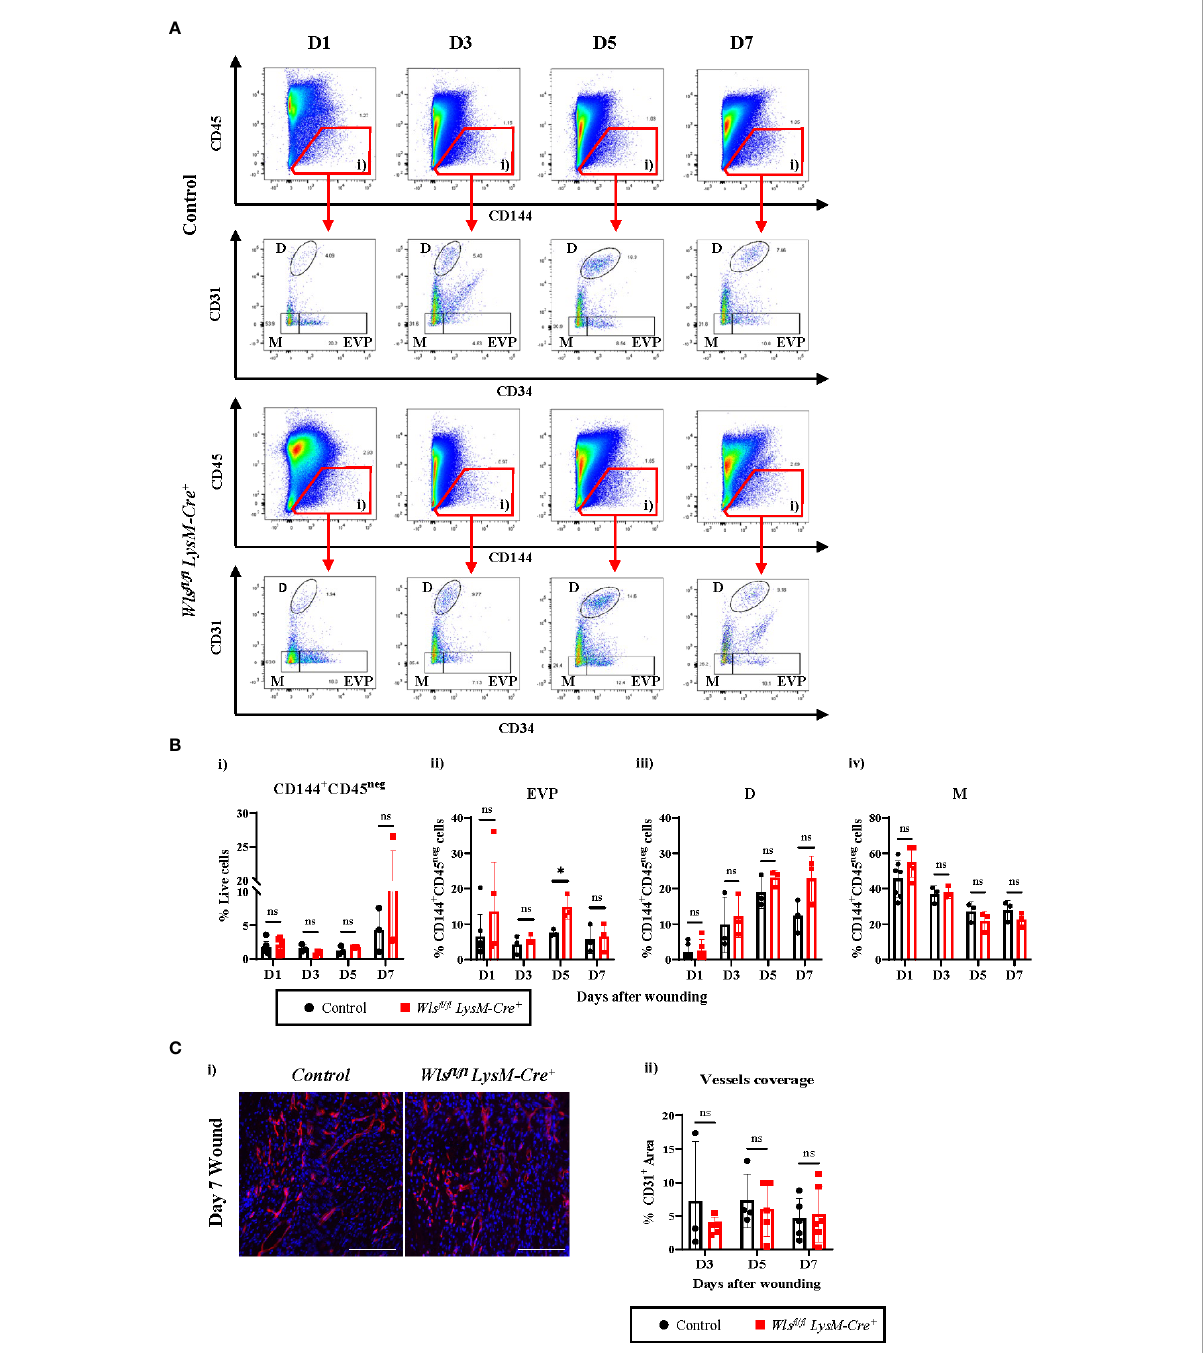
FIGURE 4 Wls knockout in myeloid cells does not alter blood vessel regenerations in wound healing. (A) Representative fl ow cytometry analysis of the granulation at day 1, day 3, day 5 and day 7 showing progressive changes in the endothelial hierarchy as the wound heals. Total endothelial cells were gated as CD144 + CD45 neg cells (gate i). These were further fractioned as CD31 neg CD34 + EVP, CD31 + CD34 + D and CD31 neg CD34 neg M cells. (B) Flow cytometry analysis showing percentage of live (i) CD144 + CD45 neg cells and (ii) EVPs, (iii) D and (iv) M cells in the granulation of Wls fl / fl LysM-Cre + and control mice across the wound healing time course. No major alteration was observed in the percentage of the endothelial cells except EVPs which were elevated at day 5 in the Wls fl / fl LysM-Cre + mice. (C)(i) Representative immuno fl uorescence staining of the endothelial marker CD31 (red) and DAPI (blue) in the granulation of Wls fl / fl LysM-Cre + and Wls fl / fl LysM-Cre neg mice at day 5 post wounding. (Scale bar = 100µm) (ii) Quanti fi cation of CD31 + staining in granulation at day 3, day 5 and day 7 showing no signi fi cant difference in the blood vessels of Wls fl / fl LysM-Cre + and Wls fl / fl LysM-Cre neg wounds. Data are represented as mean ± SD. Statistical analysis was performed using unpaired Student t-tests. ns = not signi fi cant, * = p<0.05. Data are representative of 3-5 individual animal